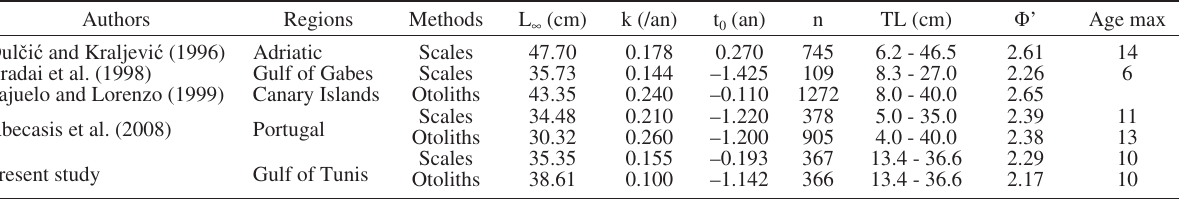
Table 3. – Biogeographic comparison of von Bertalanffy growth function parameters and growth performance index ( Φ ’) of Spondyliosoma cantharus .